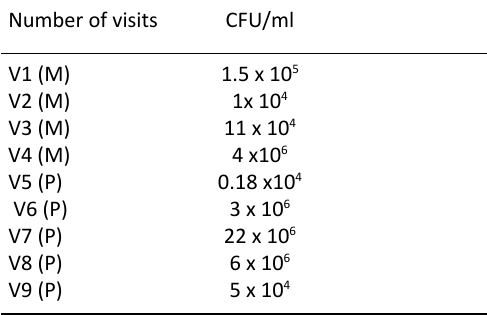
Table 3. Morphological characterization of bacterial isolates from Domiaty cheese Number Cell Gram Mackonckyagar Morphological characterization of isolates shape stain Shape Margin Color size Circular Entire Cream Big Circular Entire Cream Small Circular Entire Cream Big - Circular Entire Cream Small Circular Entire White Small Circular Entire White Small Circular Entire Cream Small